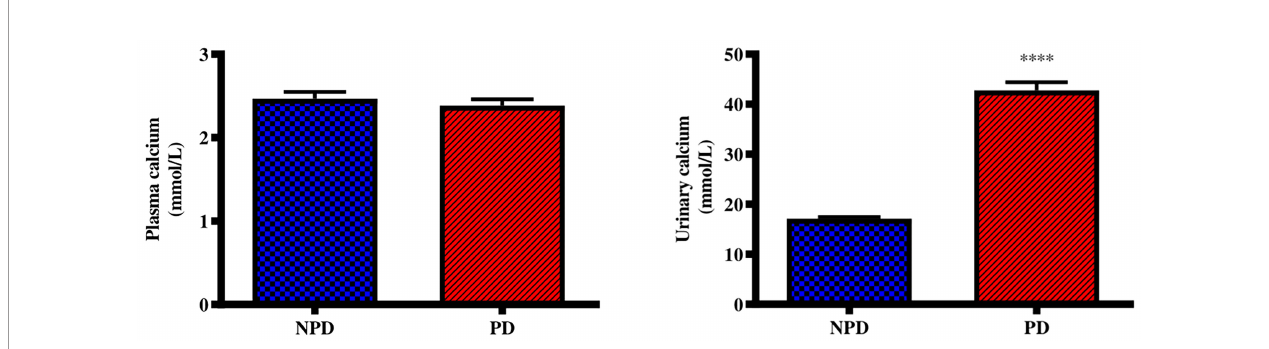
FIGURE 2 | Plasma and urinary calcium concentrations in the non-pre-diabetic (NPD) group and diet-induced pre-diabetic group (DIPD) (n=6, per group). Values are presented as mean ± SEM. ****= p < 0.0001 by comparison with NPD.